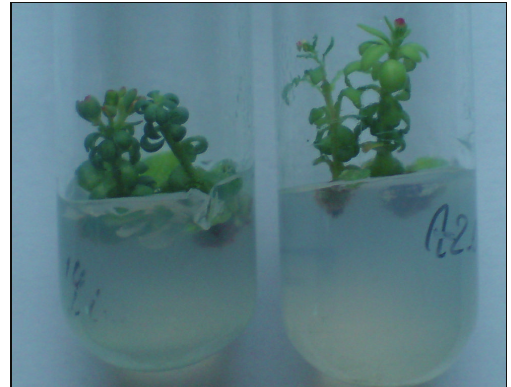
Figure 2: Rh. rosea plant regeneration from in vitro seedling apical buds on Murashige and Skoog (MS) [64] basal medium enriched with 2 mg/L zeatin, 0.2 mg/L IAA, and 1000 mg/L casein